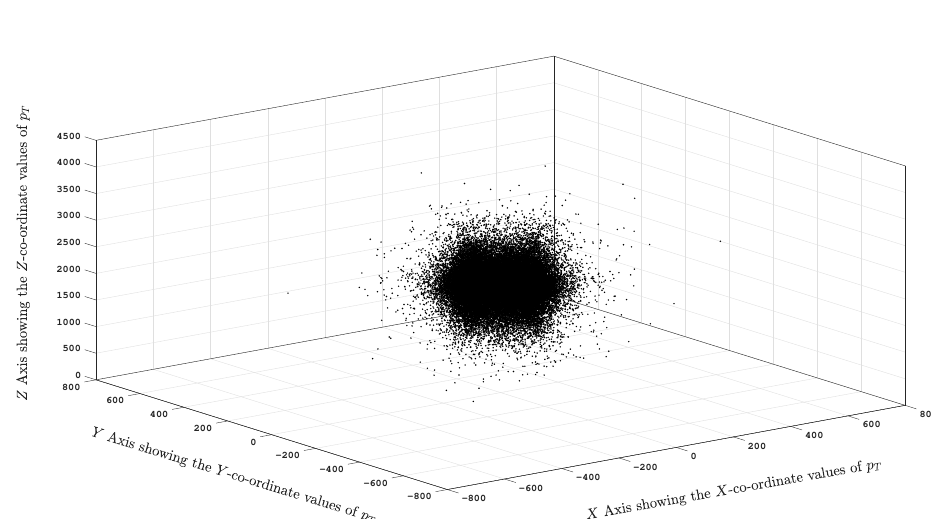
Figure 5. Data space— [ x , y , z ] ss